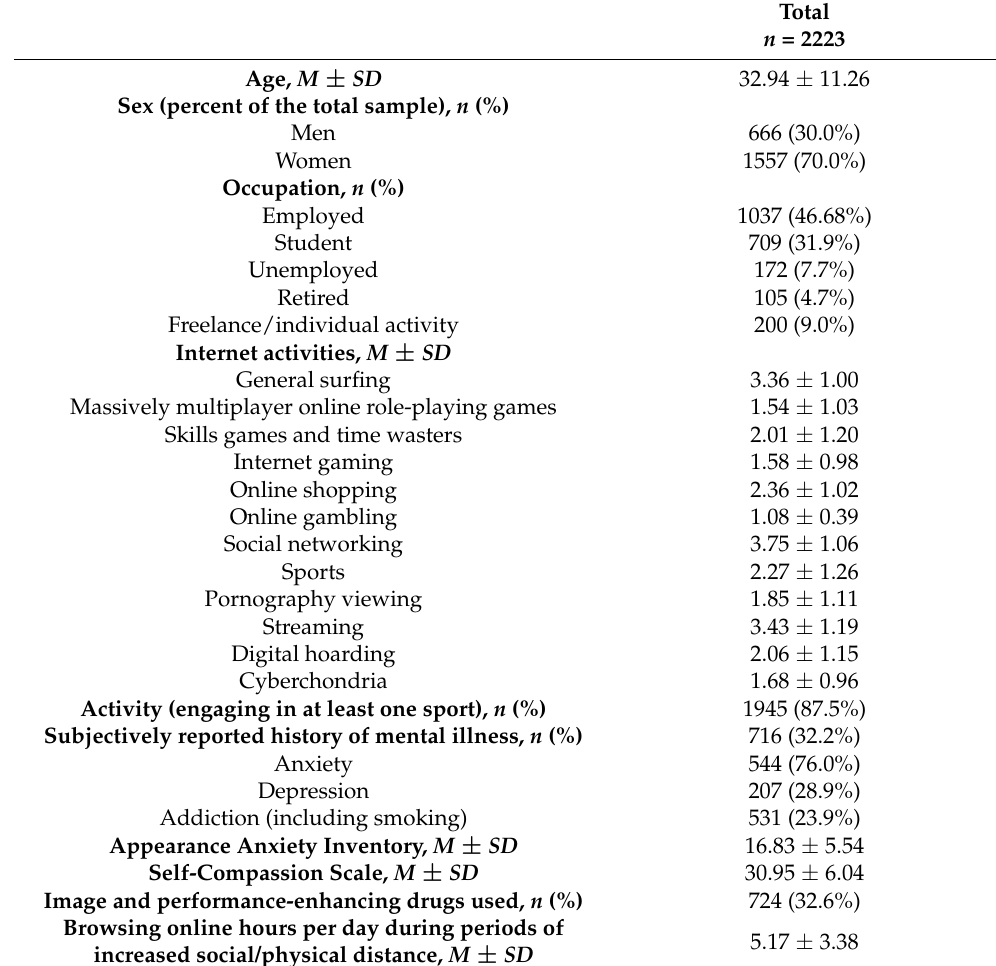
Table 1. Demographic characteristics, internet activities, Appearance Anxiety Inventory (AAI), and Self-Compassion Scale (SCS)